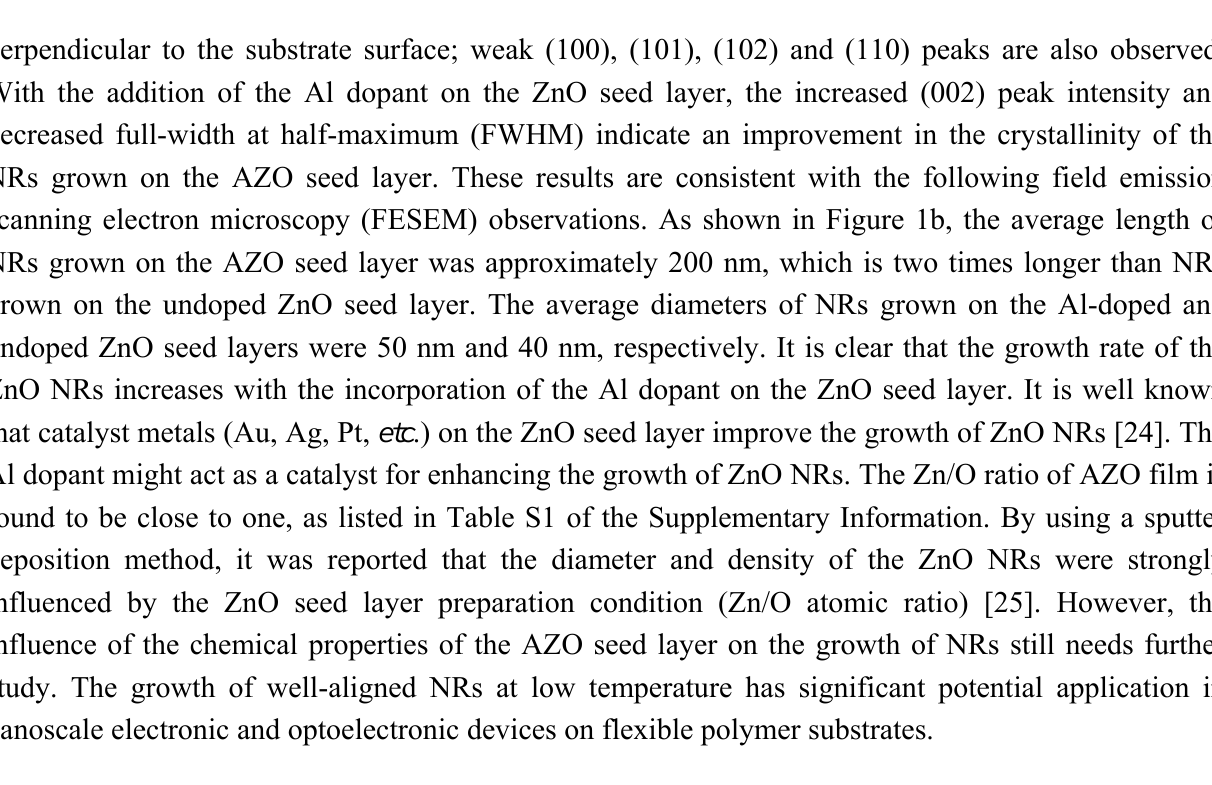
Figure 1. ( a ) XRD patterns and ( b ) cross-sectional field emission scanning electron microscopy (FESEM) images of ZnO nanorods (NRs) grown on undoped and Al-doped ZnO seed layer (20